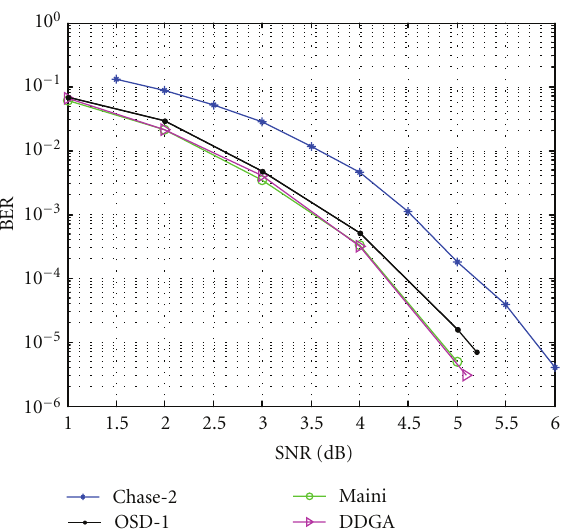
Figure 16: Performances of Chase-2, Maini, DDGA, and OSD-1 algorithms for BCH (63,57,3) code.